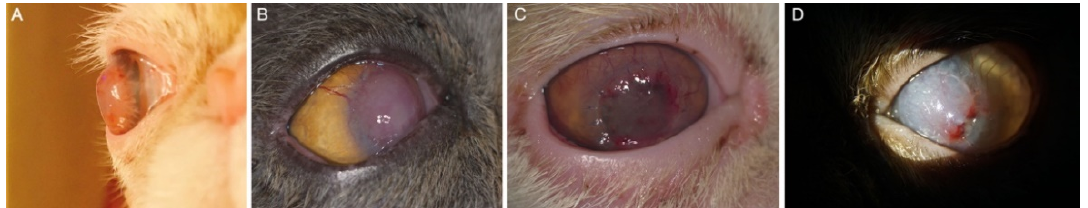
Figure 3. Potential complications after acellular bioengineering cornea lamellar keratoplasty. ( A , B ) Protrusion of the graft (3–4 weeks post-op); ( C ) Obvious vascularization of the graft (2–3 weeks post-op); ( D ) Partial dehiscence of the graft (2 weeks post-op); ( A – D ) Case number: 6, 12, 53 and 29. Table 1. Grade of transparency of the cornea. Figure 2. Photographic records of some cases were included in the present study. The first column is at presentation; the second column is 2–5 weeks after keratoplasty; the third column is 3–4 months after keratoplasty; and the fourth column is at the last recheck. ( A1 , B1 , C1 , D1 , E1 and F1 ) By cam- era; ( A2 , B2 , C2 , D2 , E2 and F2 ) By slit-lamp biomicroscopy; ( A1 – F2 ) Case number: 1, 2, 6, 18, 24 and